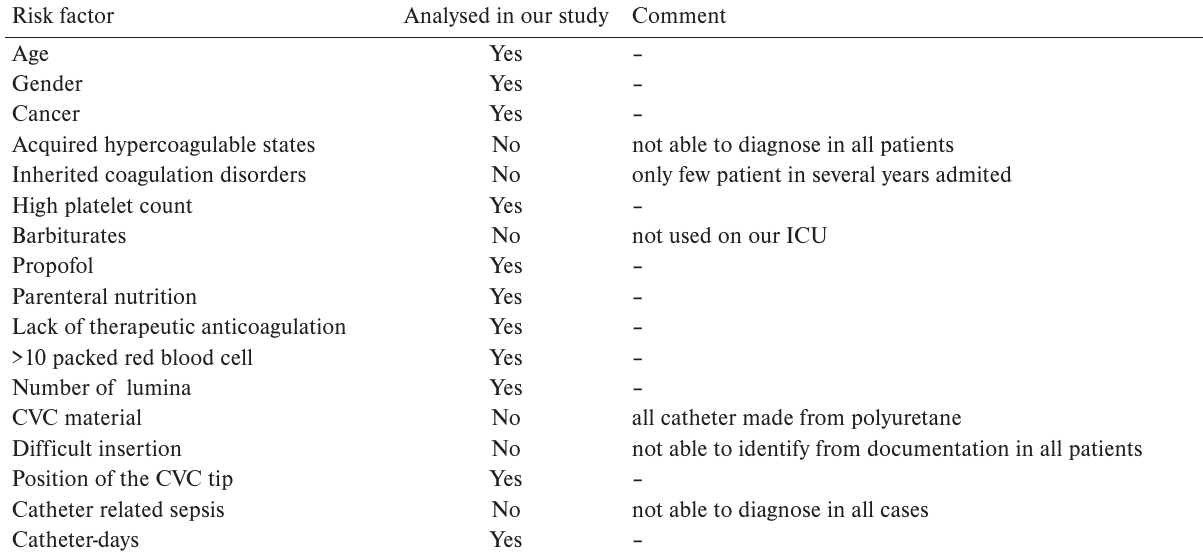
Table 2. Risk factors of CR-DVT identified in